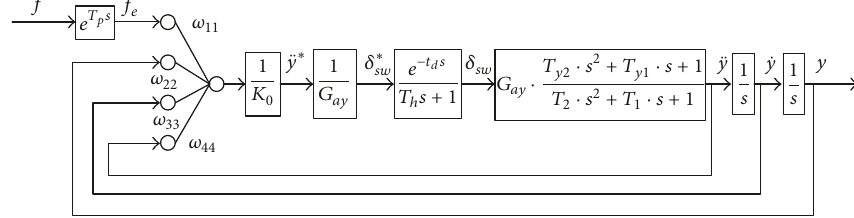
Figure 4: Error analysis